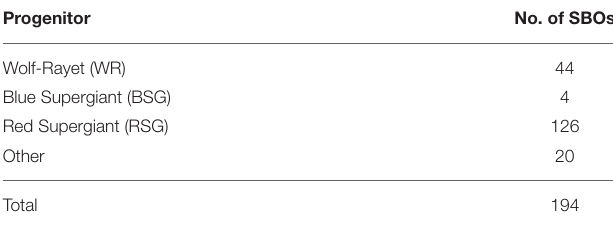
FIGURE 2 | Broadband (115–180nm) light curves for a range of SN explosions. In the models, we vary initial stellar radius (red and magenta = 10 12 cm, blue and green = 10 13 cm), ejecta mass (dotted = 8M ⊙ , all others = 4M ⊙ ), explosion energy (dot-dashed = 6 × 10 51 erg, all others = 10 51 erg), and density profile ( ρ = r − α ; dashed for α = 2.5, all others for α = 0). All of these factors alter light-curves and with limited data from the primary peak, it is difficult to distinguish these. ATO would disentangle these differences.